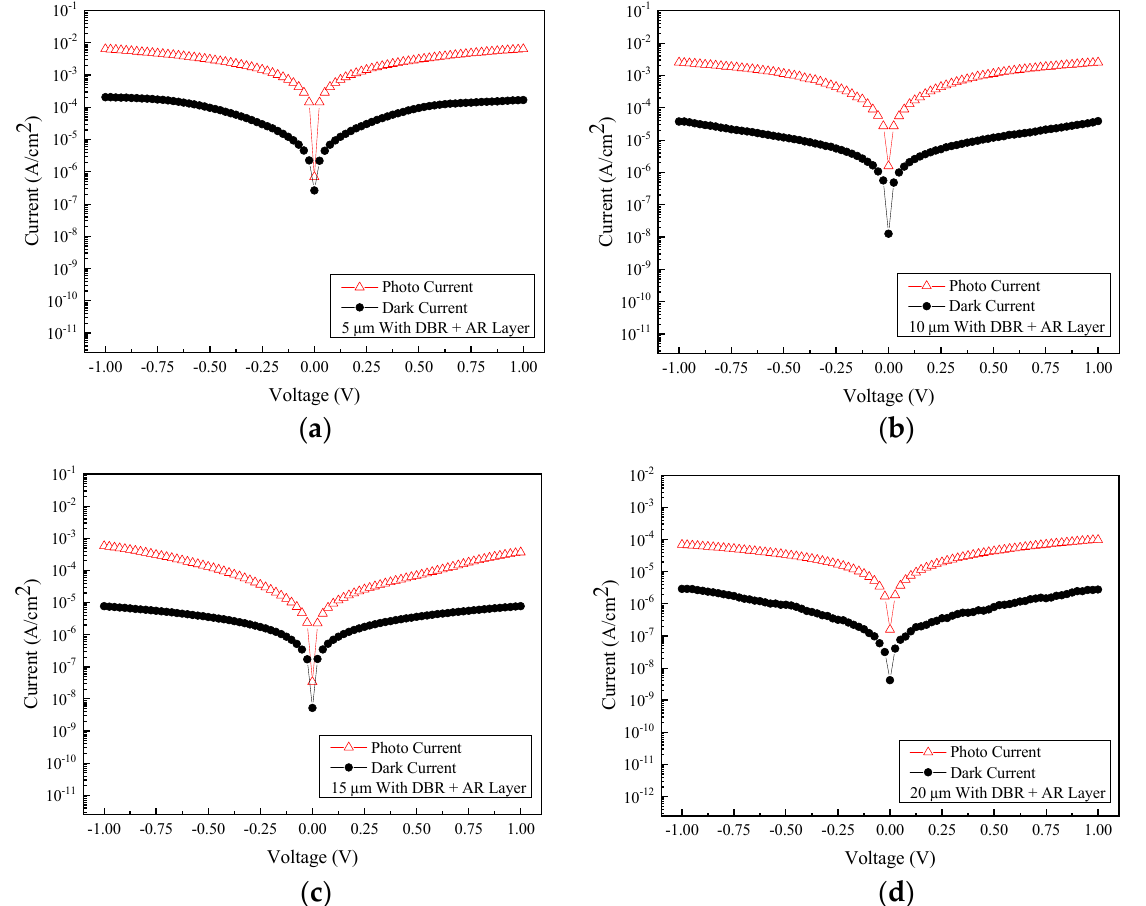
Figure 15. The respective photocurrent and dark current are recorded from the MSM PDs with four different electrode sizes with and without the illumination of 2000 nm light. All samples are coated with DBR mirror stacks: ( a ) 5 µm, ( b ) 10 µm, ( c ) 15 µm, and ( d ) 20 µm.